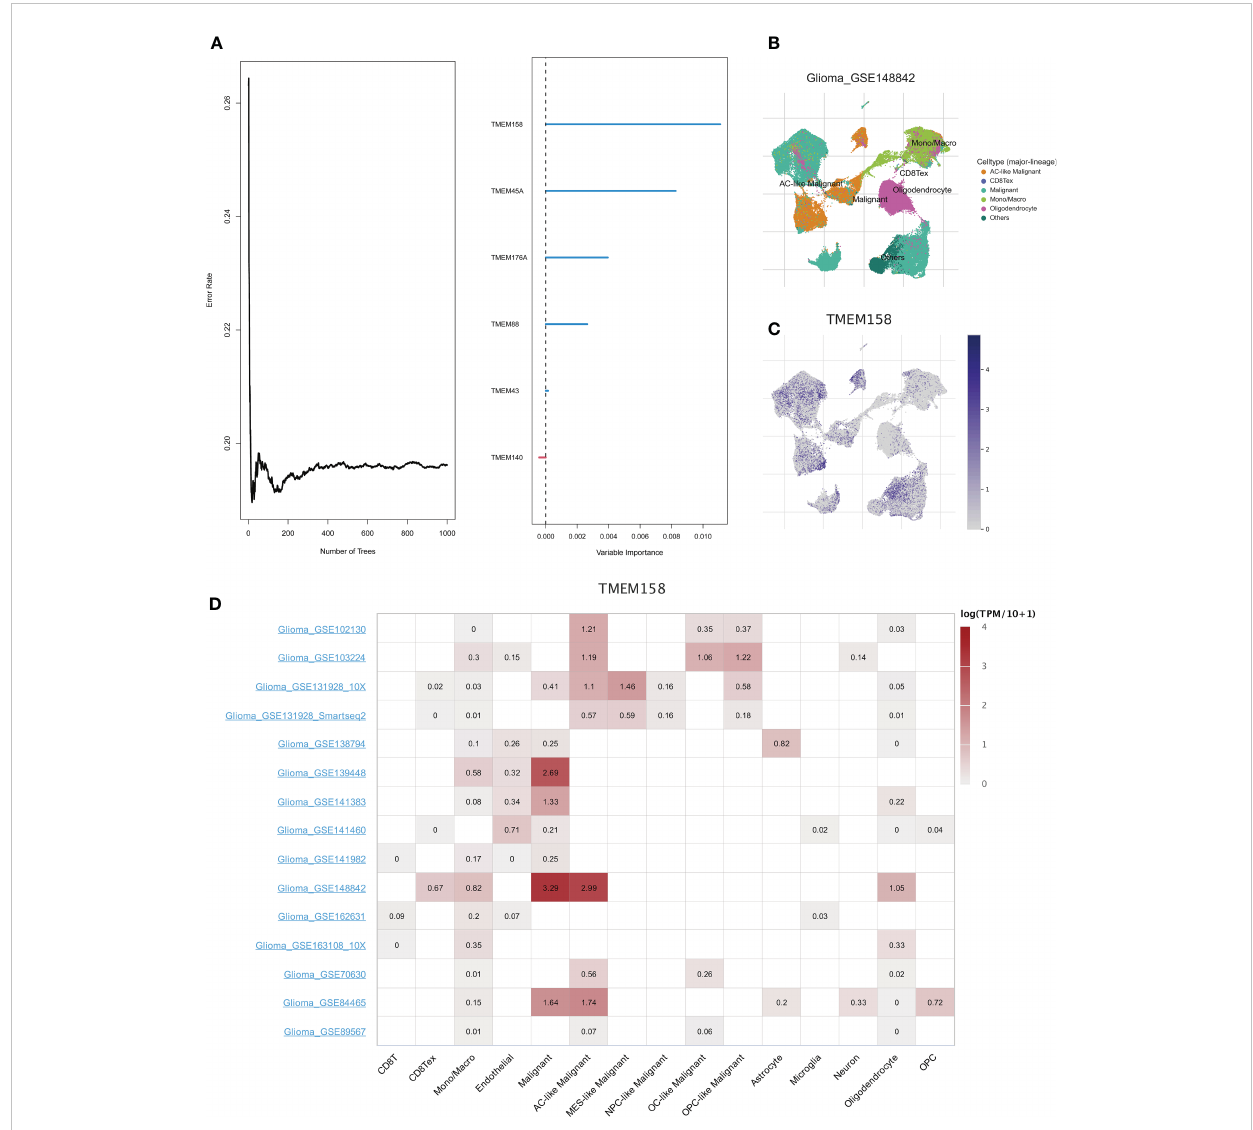
FIGURE 7 Identi fi cation of hub genes using the random forest algorithm. (A) The graph shows the error rate of the data as a function of the classi fi cation tree and the out-of-bag importance values for the predictors. (B) Annotation of all cell types in dataset GSE148842 based on the TISCH database. (C, D) Expressions of TMEM158 in GSE148842 and other Glioma single-cell